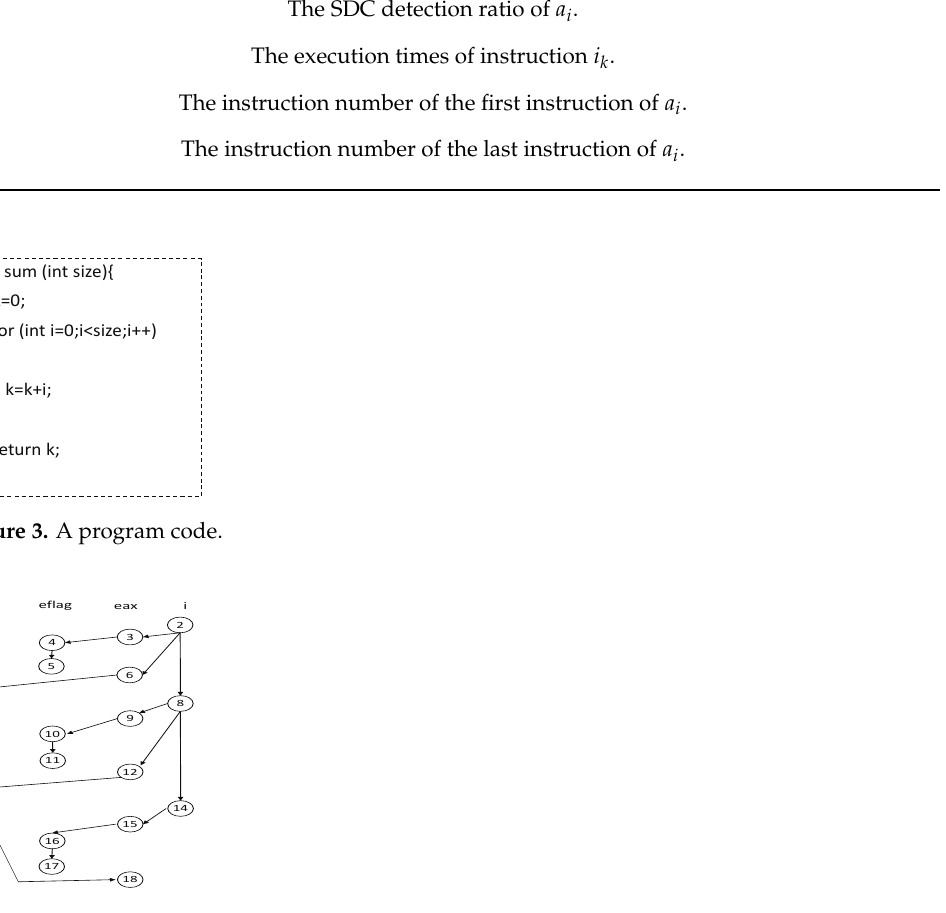
Figure 4. The dynamic dependency graph with a size of 2. Table 2. Instructions and